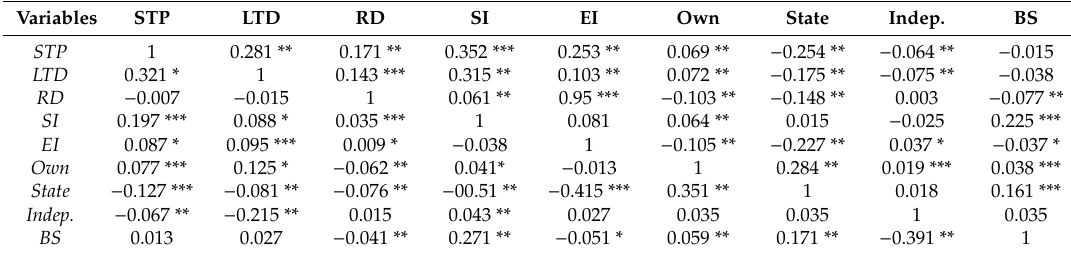
Table 4. Spearman and Pearson correlation analysis.